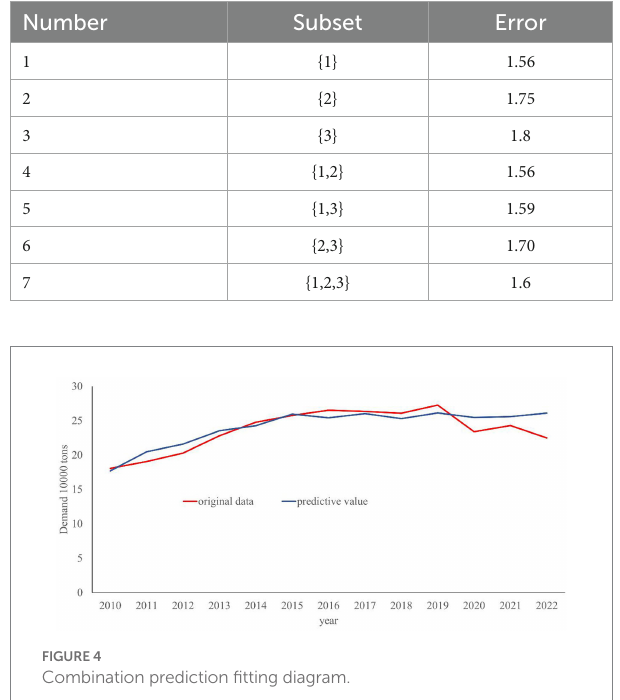
TABLE 5 Subset error of combined prediction model.